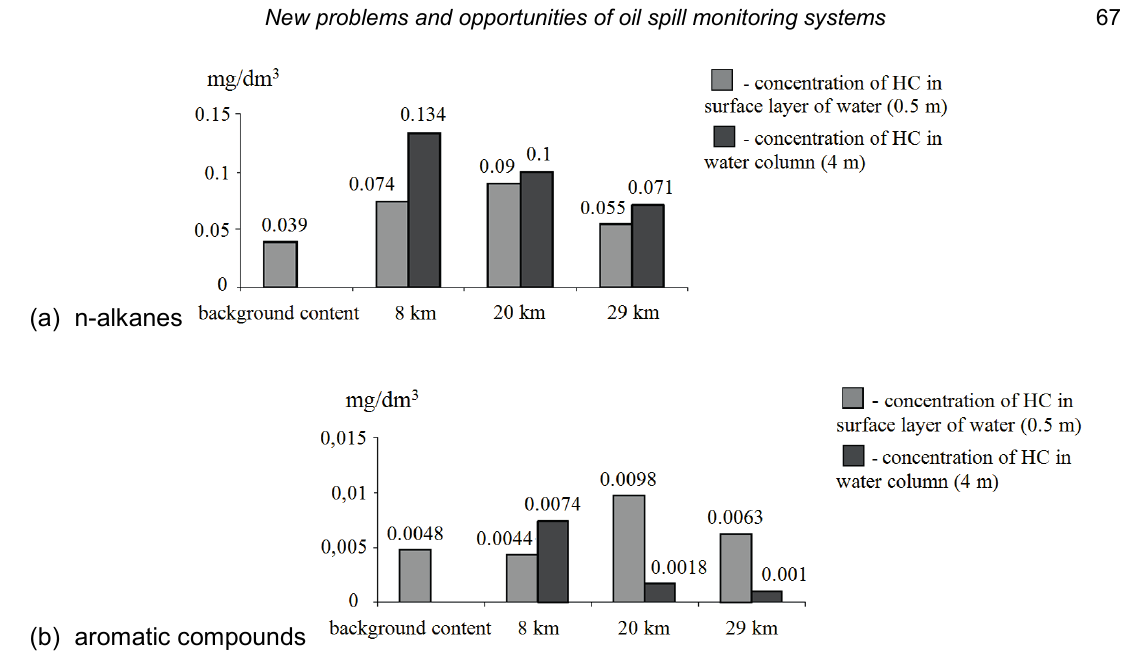
Fig. 2 Distribution of dissolved n-alkanes (a) and arenes (b) at different distances from the accident